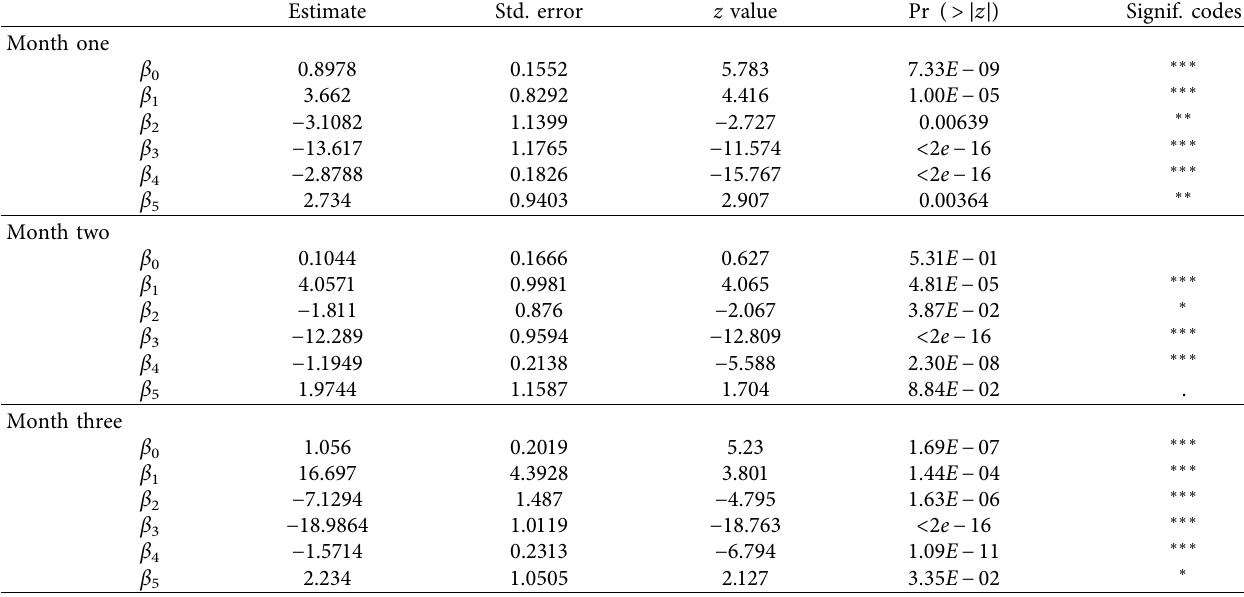
Table 2: Parameter estimates and relevant statistics of the logistic regression